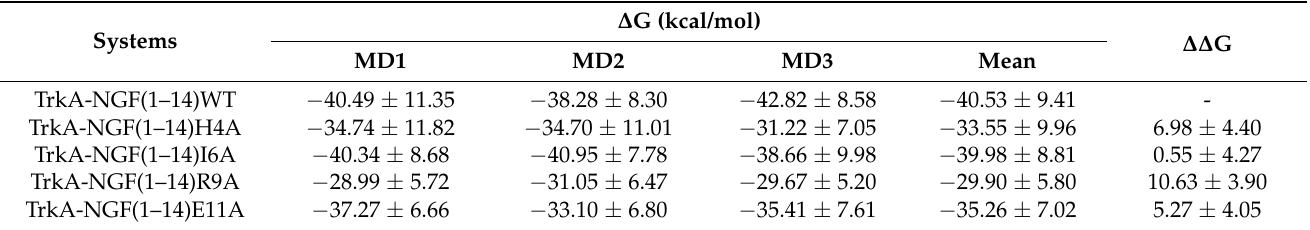
Figure 10. RMSD profiles of TrkA backbone in complex with NGF(1–14) mutants H4A ( A ), I6A ( B ), R9A ( C ) and E11A ( D ). R9A ( C ) and E11A ( D ). Table 2. ∆ G values calculated from each MD run performed on TrkA in complex with the mutated NGF(1–14) and impact of the mutation on the binding free